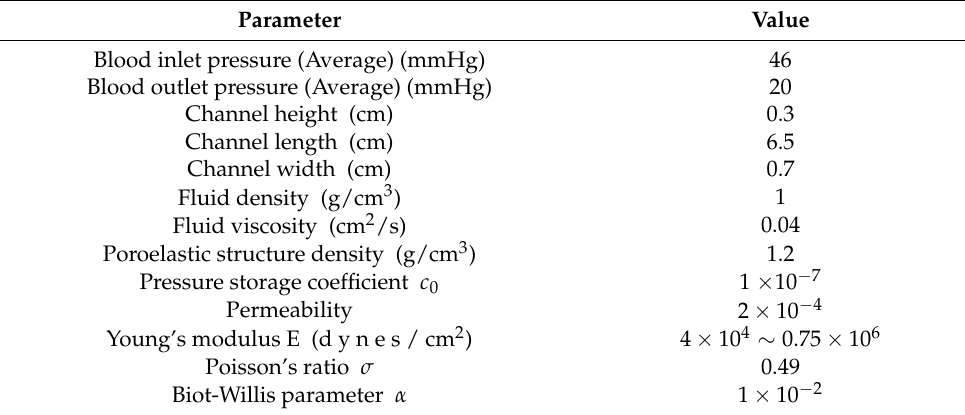
Table 1. Parameters for FSI